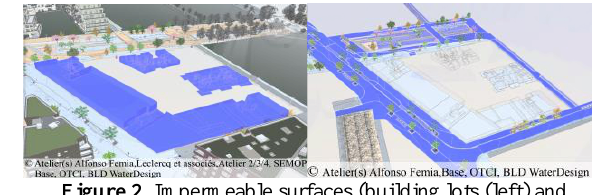
Figure 2 . Impermeable surfaces (building lots (left) and impermeable public spaces (right))